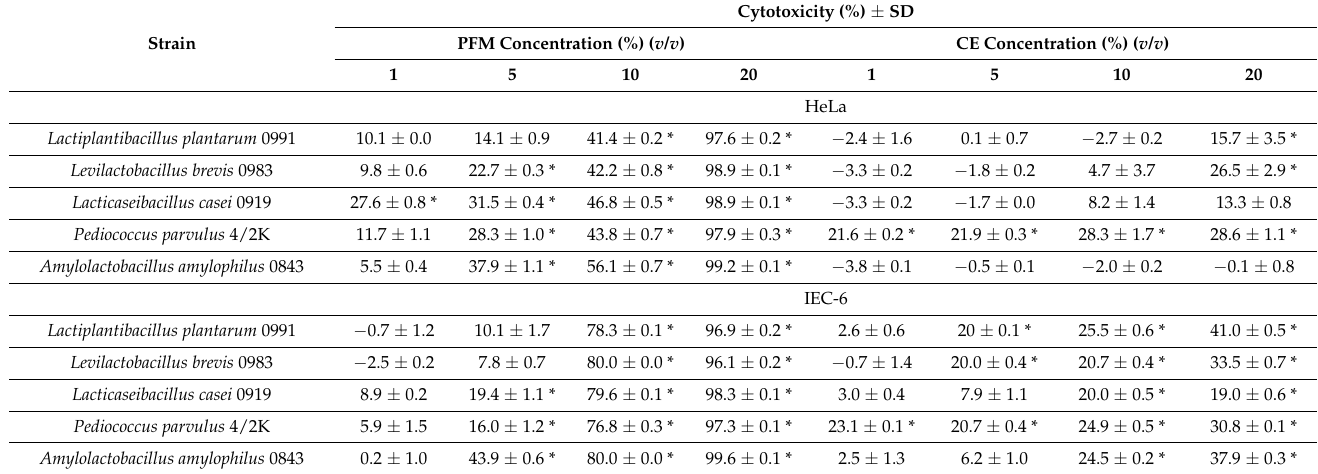
Table 2. Antiproliferative and cytotoxic activity of post-fermentation media (PFM) and cell extracts (CEs) in the HeLa and IEC-6 cell lines after 48 h exposition. Each data point represents the mean ± SD, n ≥ 4. * Results are significantly different from unexposed control cells, p ≤